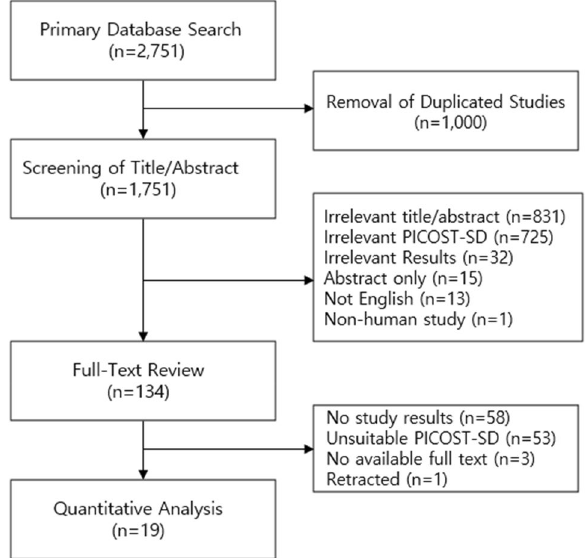
Figure 1. PRISMA